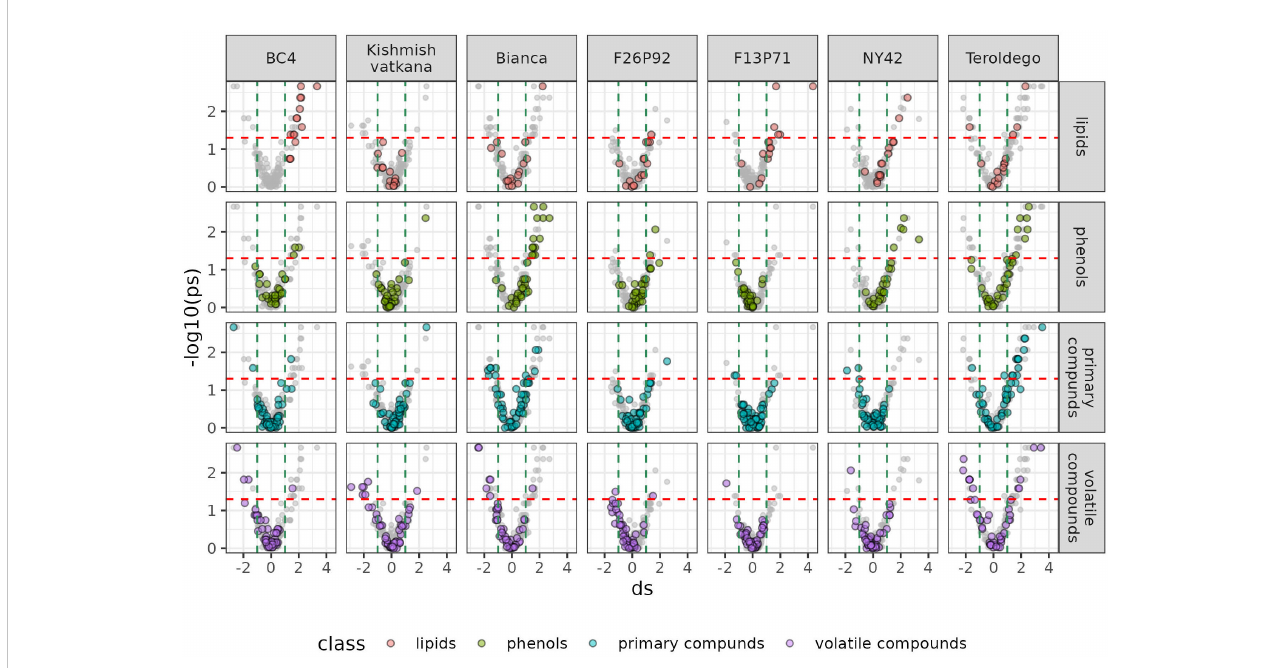
FIGURE 6 Metabolites signi fi cantly modulated by the infection (up- and down- accumulated) by class of compounds in all seven genotypes at 48 hpi in the two years of data analysis (2019 – 2021). The colors identify the different chemical classes (red for lipids, green for phenols, blue for primary compounds, and violet for volatile organic compounds) and “ ds ” represents the calculated Cohen ’ s d